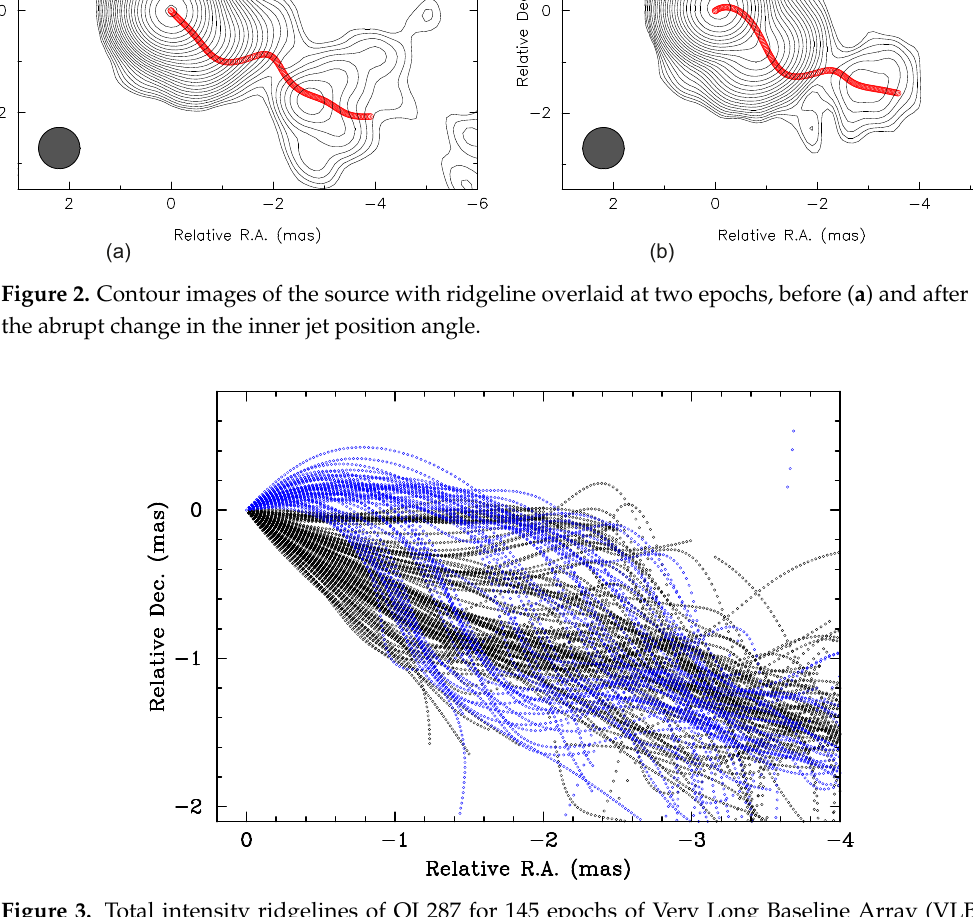
Figure 3. Total intensity ridgelines of OJ 287 for 145 epochs of Very Long Baseline Array (VLBA) observations carried out at 15 GHz within a period 1994–2019: The origin of coordinates corresponds to the position of the 15 GHz very large baseline interferometry (VLBI) core.